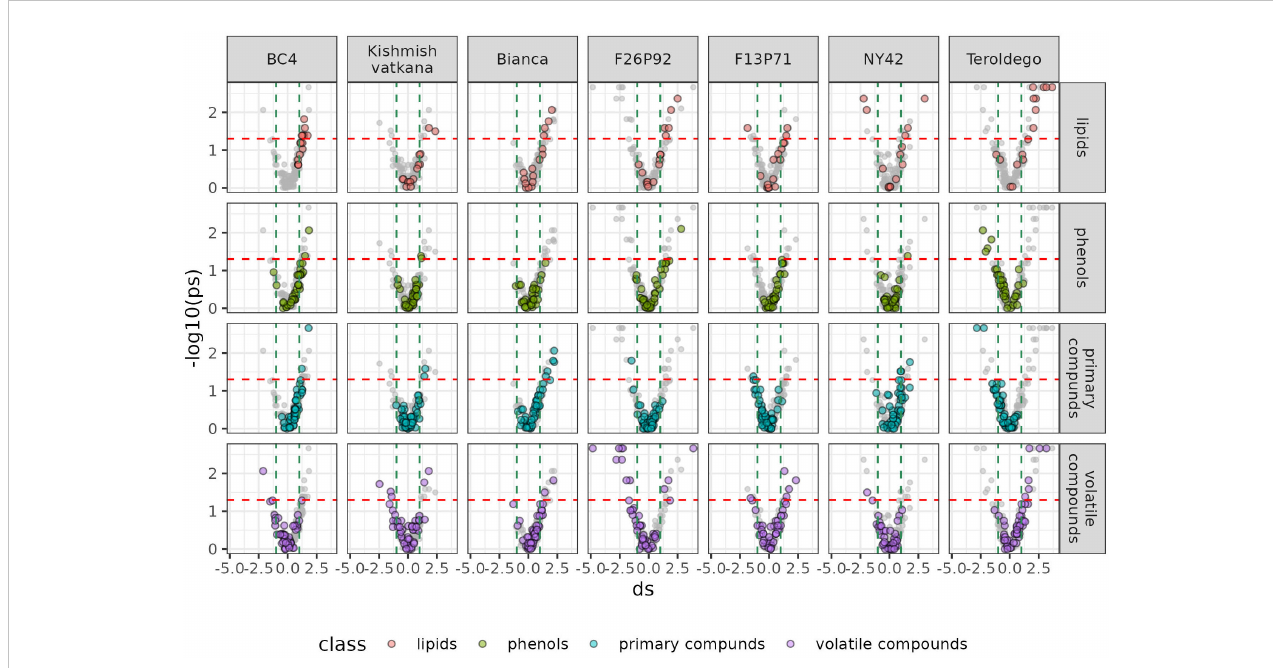
FIGURE 5 Metabolites signi fi cantly modulated by the infection (up- and down- accumulated) by class of compounds in all seven genotypes at 24 hpi in the two years of data analysis (2019 – 2021). The colors identify the different chemical classes (red for lipids, green for phenols, blue for primary compounds, and violet for volatile organic compounds) and “ ds ” represents the calculated Cohen ’ s d values.